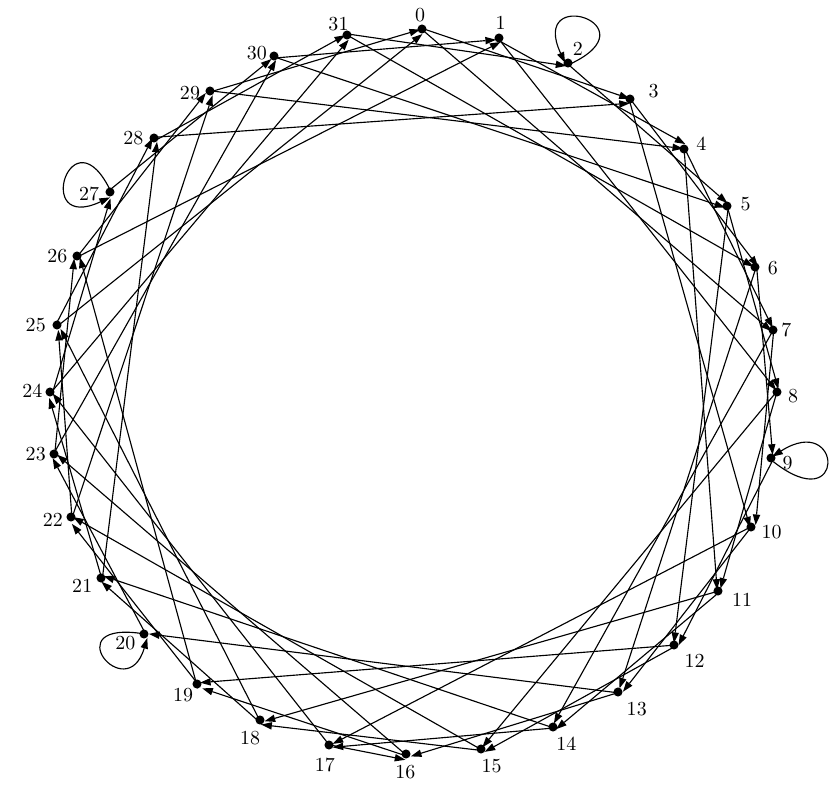
Fig. 8: A spanning 2 -diregular bieulerian subdigraph ~H 2 of ~G ′ 6